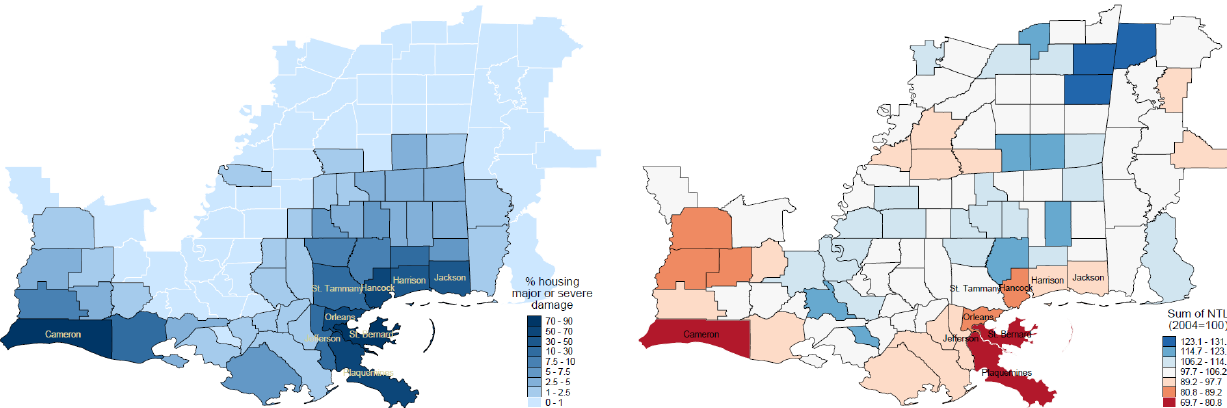
Figure 2. Housing damage and change in night light intensity in 2005. Left: percentage of occupied housing units with major or severe damage from Hurricane Katrina. Own calculations, based on U.S. Department of Housing and Urban Development (2006) data from FEMA Individual Assistance registrants and Small Business Administration disaster loan applications. Counties with major/severe damage of 15% or more are labeled in the map. Damages for the counties in western Louisiana (most notably Cameron, Vermillion, and Calcasieu) are related to Hurricane Rita, which made landfall on the coastline of Texas later in 2005. These are not to be related to the impact of Katrina but show a similar pattern of damages and night light intensity reductions. Right: night light reduction by county between 2004 and 2005, with the sum of light intensity indexed to 2004 = 100. Values below 100 indicate a reduction in light intensity with respect to 2005, while values above 100 indicate an increase. Based on own calculations. Sum of night light is based on calibrated light series using the Elvidge et al. (2014) method, discussed in detail in Sect. 2.3. Color coding is based on the standard deviation method (see Appendix Fig. A2 for the distribution of night light changes).